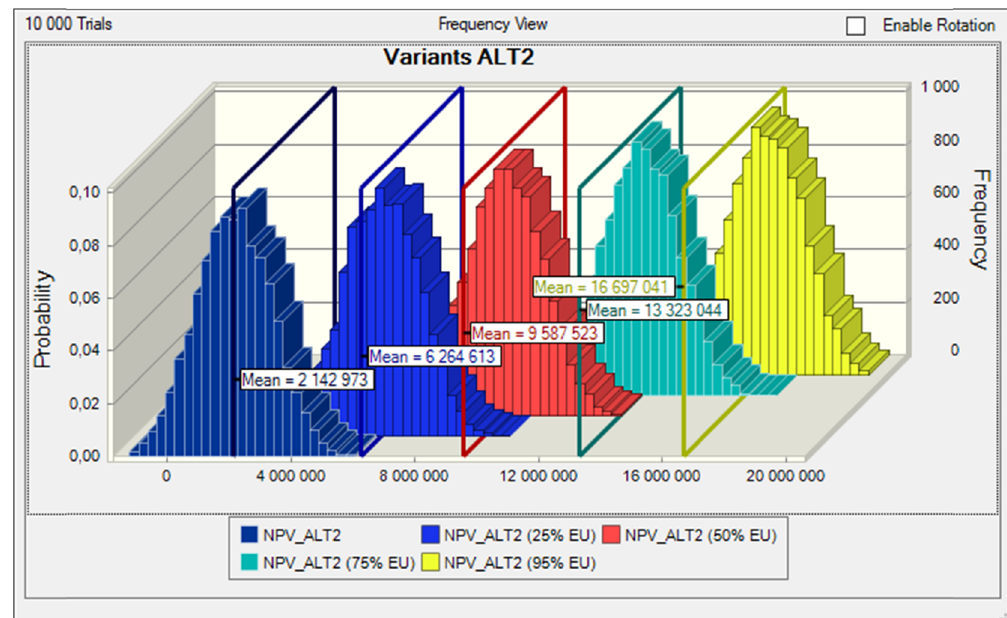
Figure 6: NPV_ALT2 at di ff erent levels of investment fi nancing